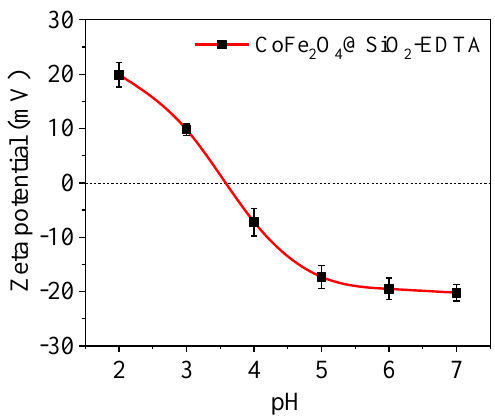
Figure 8. Zeta potential curves of CoFe 2 O 4 @SiO 2 -EDTA.